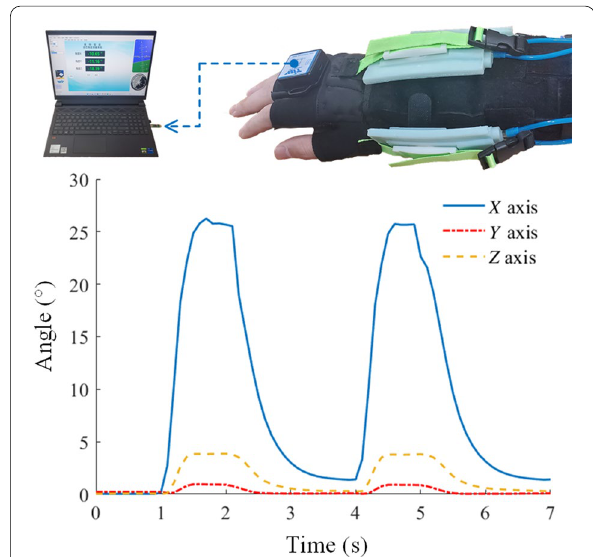
Figure 8 Changes in the angles of the three axes in the process of wrist